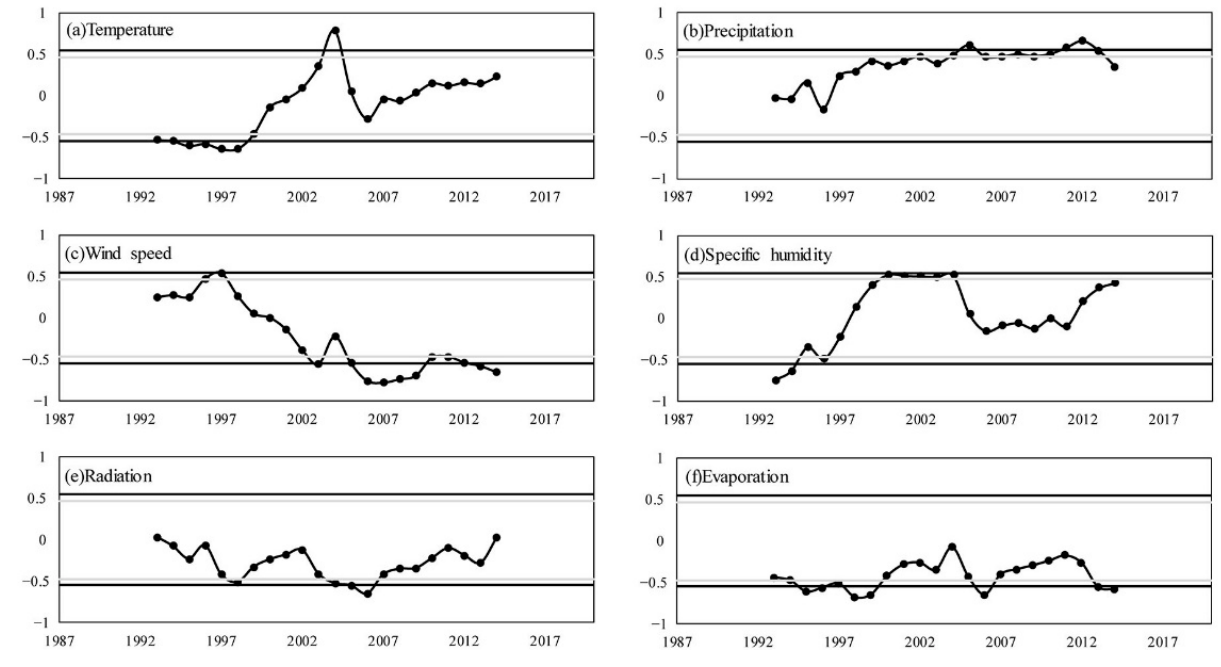
Figure 7. The 13-year sliding Correlation coefficients between lake storage anomaly and climatic factors (( a ): Temperature; ( b ): Precipitation; ( c ): Wind speed; ( d ): Specific humidity; ( e ): Radiation; ( f ): Evaporation). The gray and black lines denote correlation required for significance at the 90% and 95% levels, respectively.